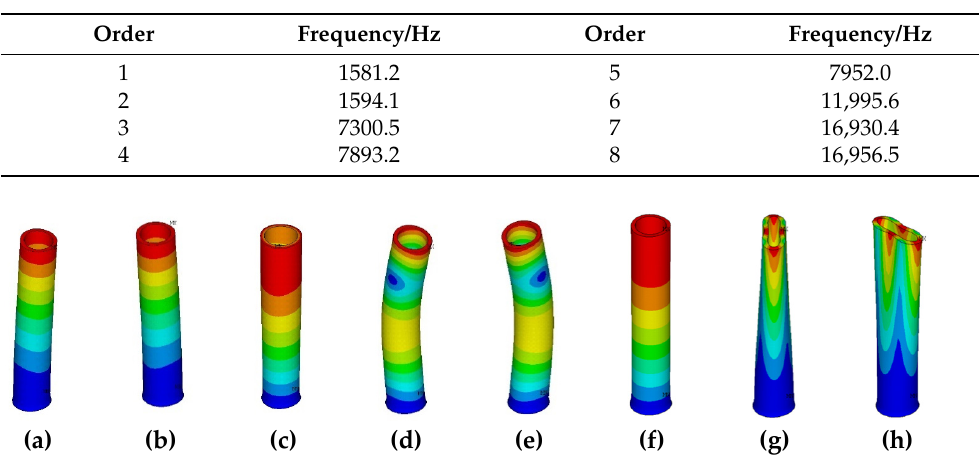
Table 1. Modal frequencies of the first eight modes.